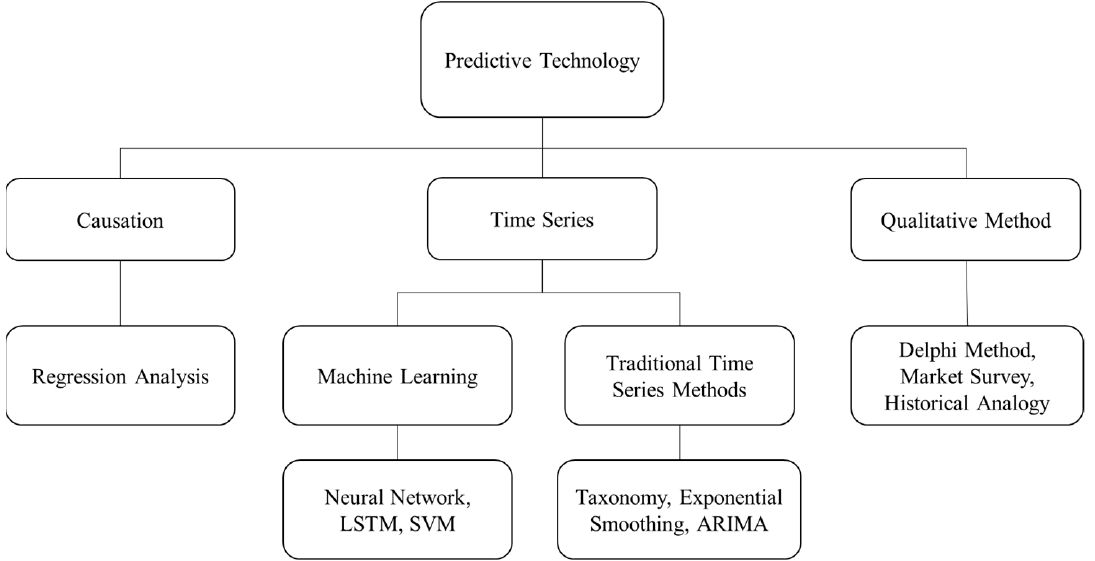
Figure 1. Prediction method hierarchy diagram.